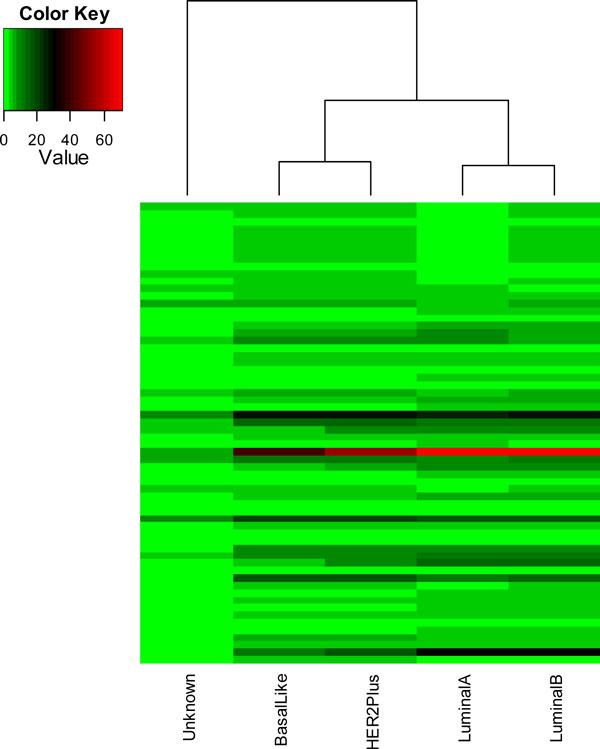
pathway profiling across four subtypes (luminal A, luminal B, HER2+, and basal-like) and additionally unknown subtype(q-value < 0.1). The y axis is pathways. Each colored cell represents number of protein in a pathway. The rows use hierarchical clustering with Euclidean distance. The columns use hierarchical clustering with Pathway Profiling distance defined in the Equation (8).